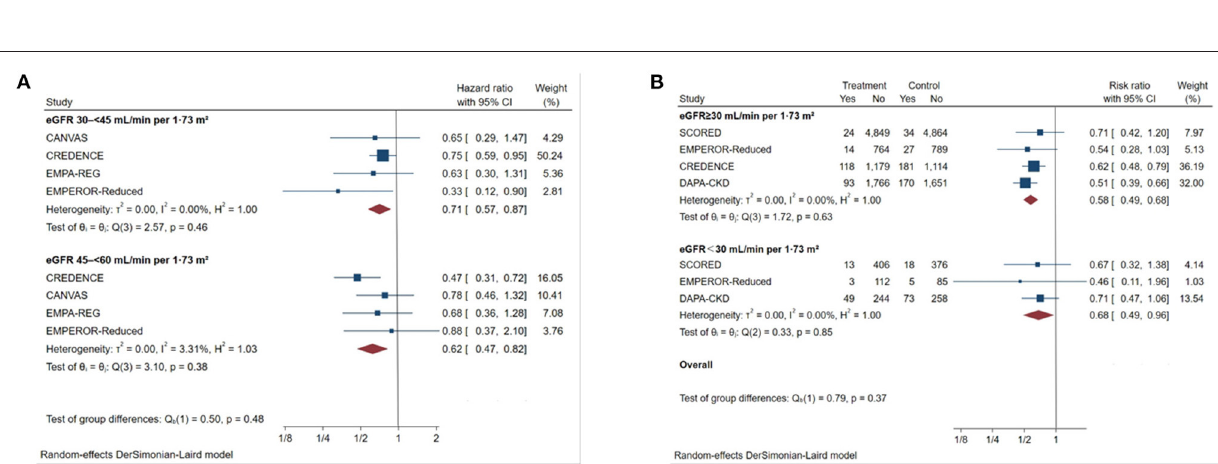
Frontiers in Medicine | www.frontiersin.org